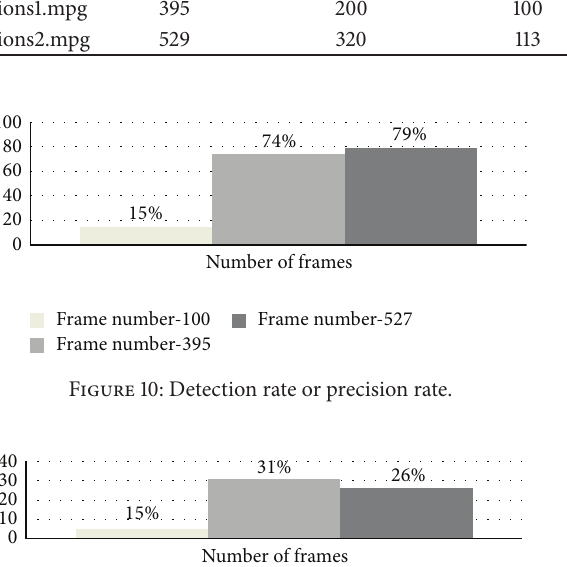
Table 3: Details of measurement of true positive (TP), false positive (FP), false negative (FN), detection rate (DR), and false alarm rate (FAR). Datasets